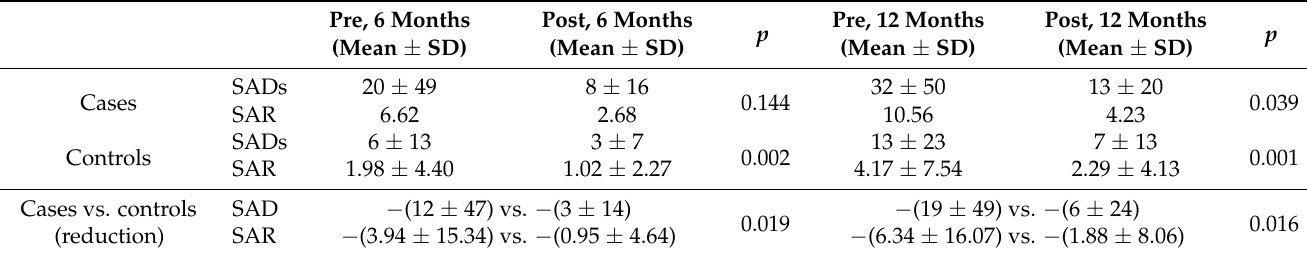
Table 3. Changes in sickness absenteeism